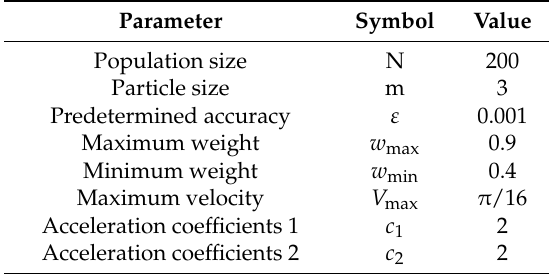
Table 2. Key parameters relevant to three bistatic